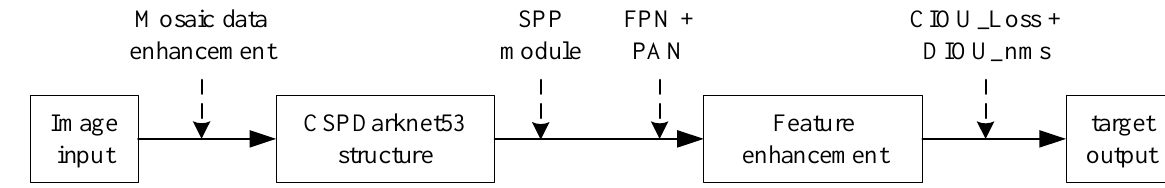
Figure 2. The structure of the improved YOLOv4.